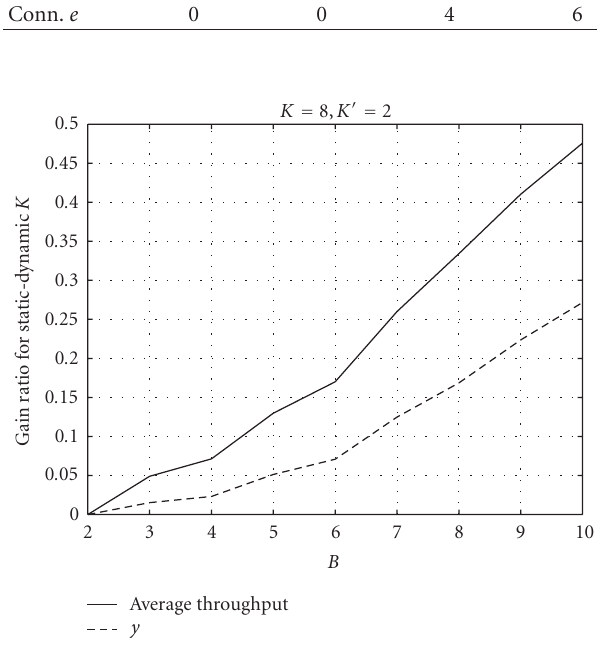
Figure 7: Gain ratio of dynamic case compared to the static one versus B (linear network).